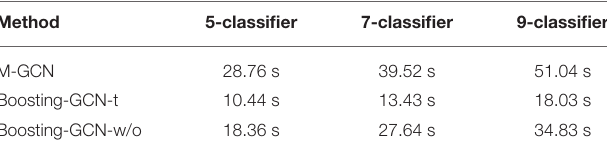
TABLE 4 | Comparison of running time when using different number of GCN base